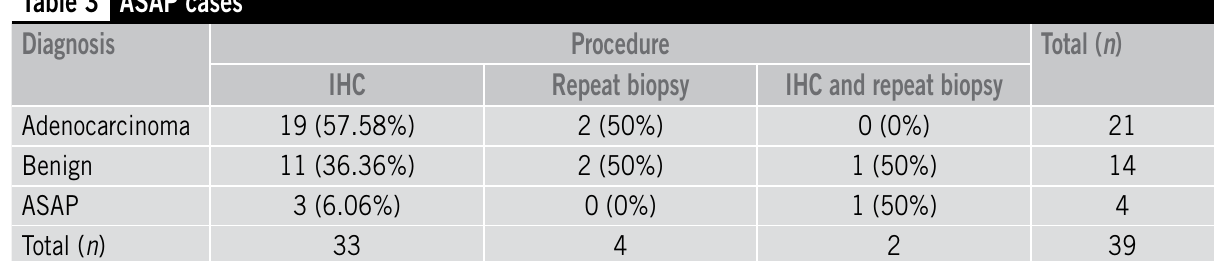
Comparisons of results of IHC and repeat biopsies for the conclusive diagnosis of adenocarcinoma